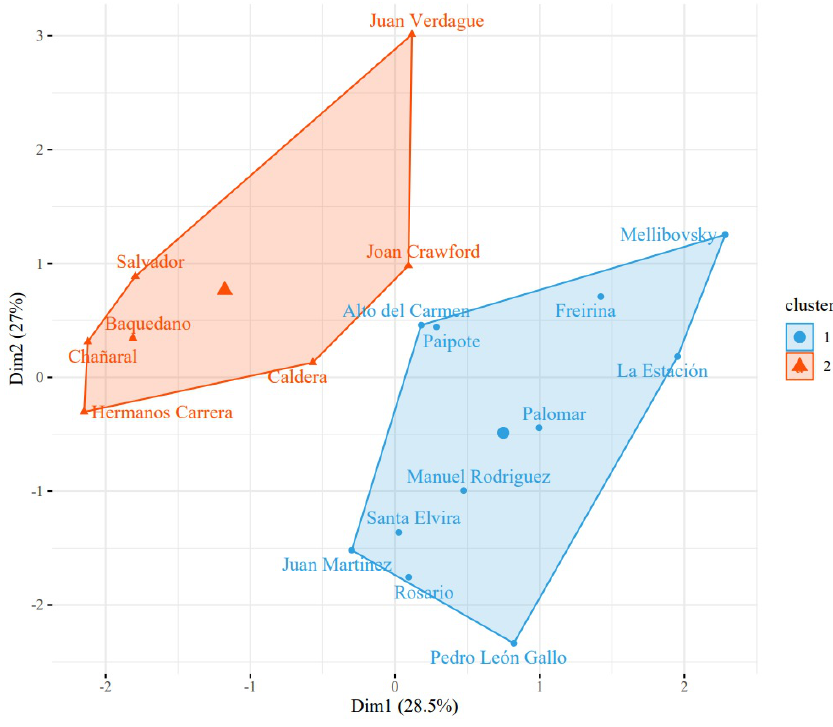
Figure 2. Two groups of primary health centers using k-means.